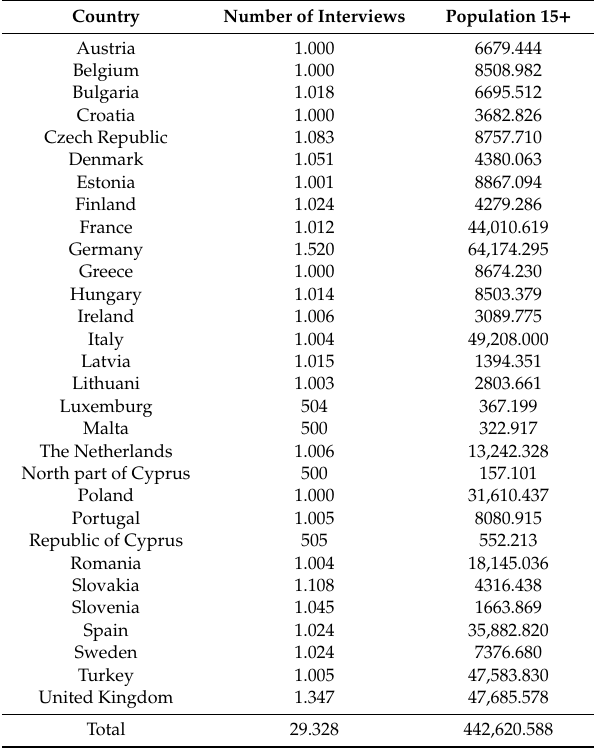
Table 1. Sample size by country, total population 15 +